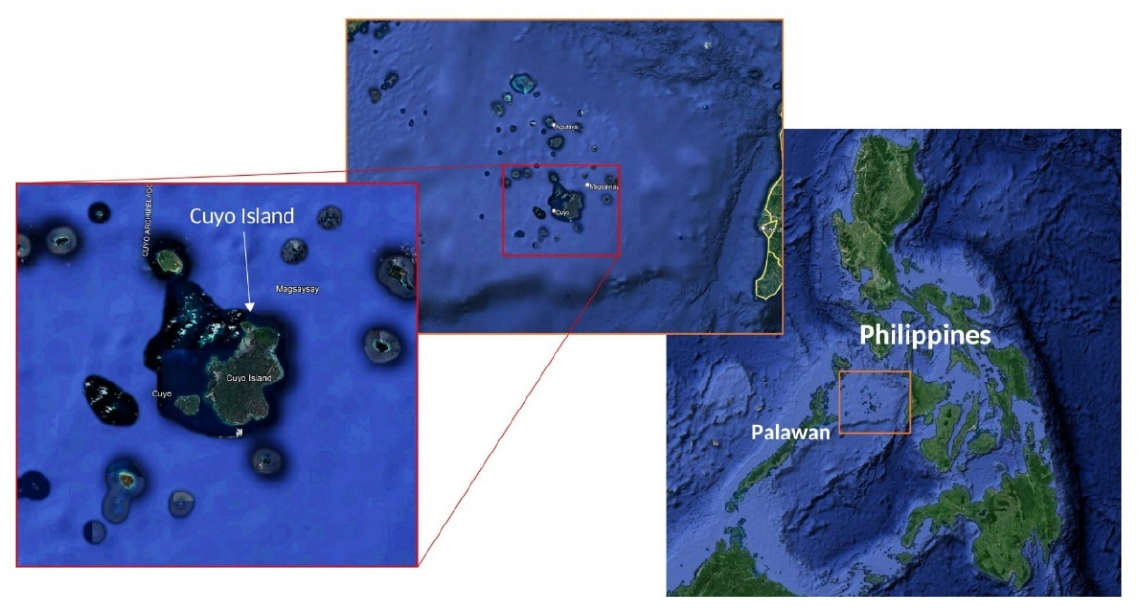
Figure 2. Map showing the study site, Cuyo Island at the northeastern part of Palawan.